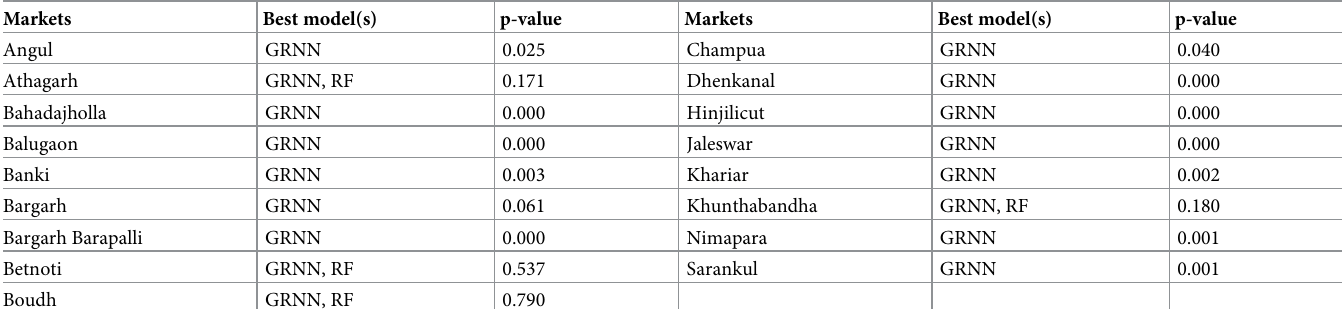
Table 5. Model Confidence Set (MCS) test results.